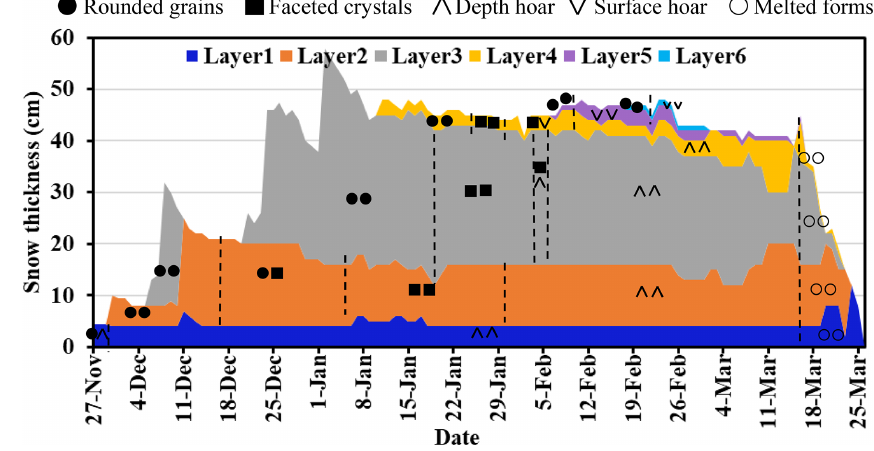
Figure 7. Daily variation in snow layers and grain shape in each layer from 27 November 2015 to 25 March 2016.